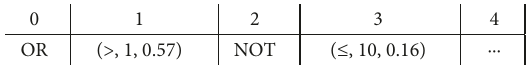
Figure 1: Single gene